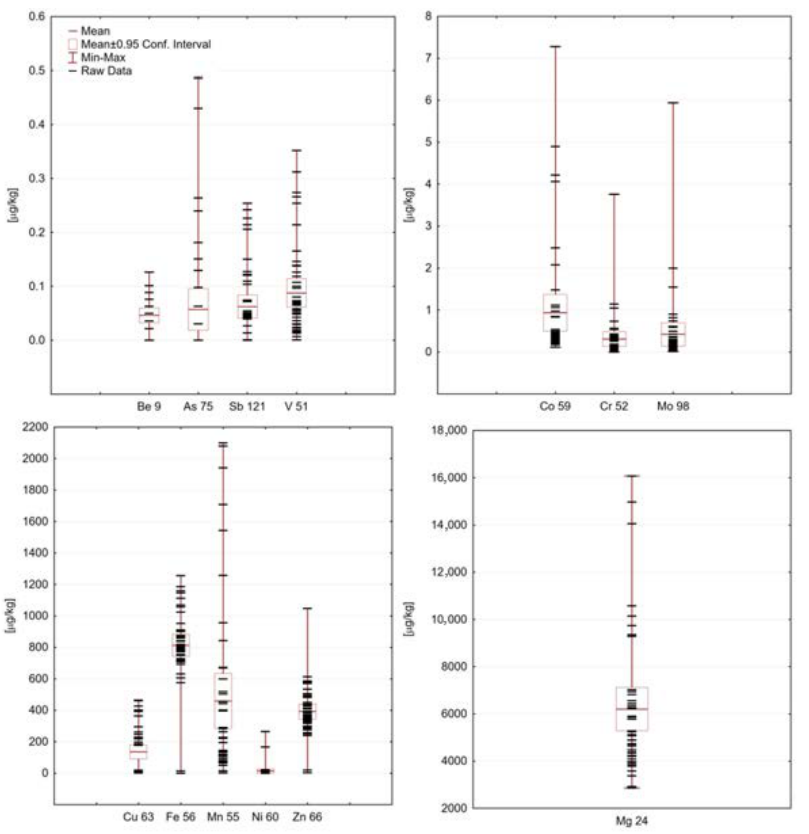
Figure 3. Variability plots of PTEs content [ µ g/kg] in honey samples. Cluster analysis (CA) was used to compare the similarities and differences in PTEs composition of honey samples. The tree diagram presented in Figure 4 clearly classifies the samples into four groups.